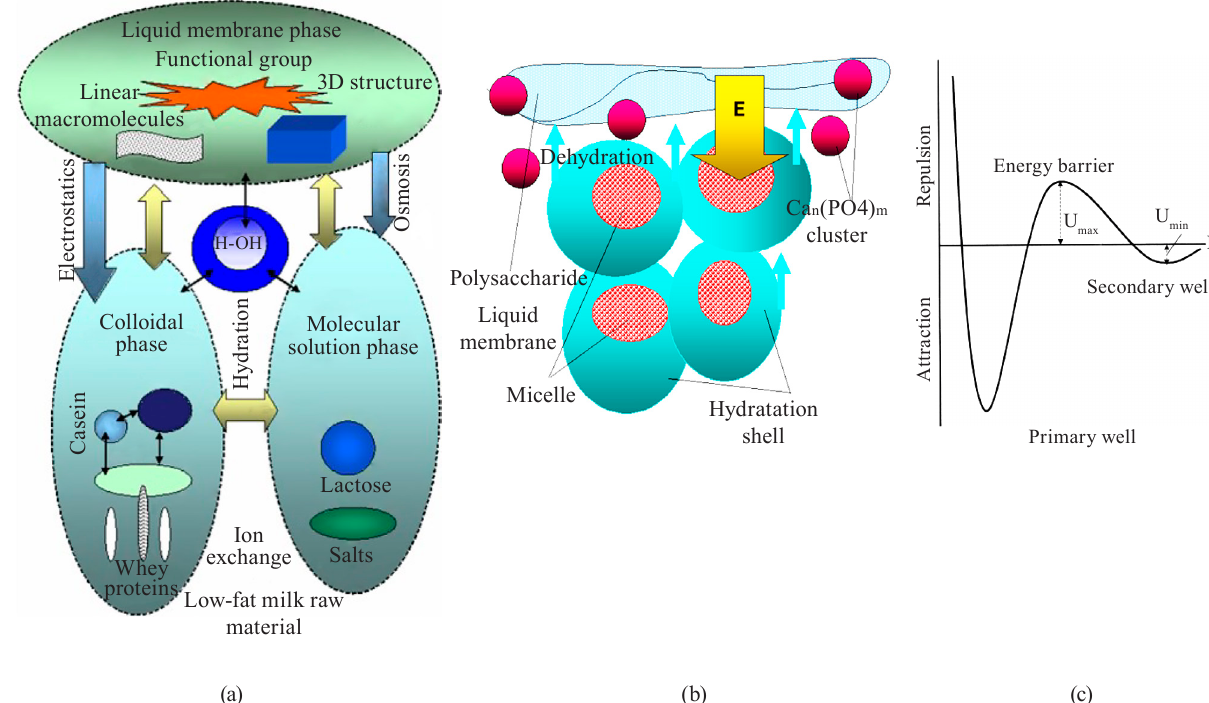
Figure 4 Hypothetical model of the interaction between the liquid membrane and the milk constituents (a); formation of associates of the first level casein micelles (b)$ and the interaction energy curve according to the DLVO theory